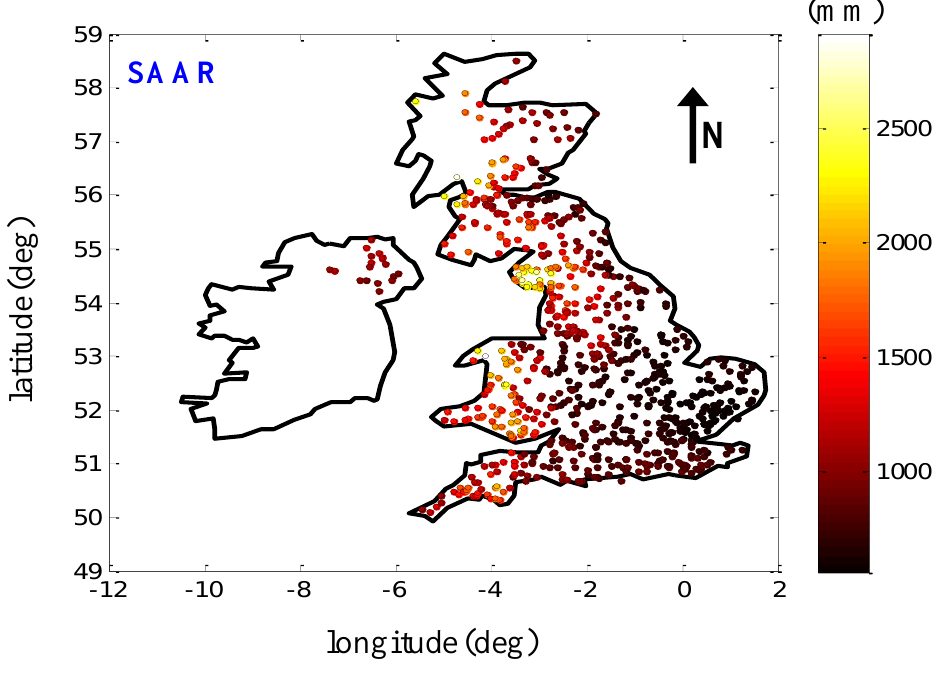
Figure 1. Spatial distribution of the average SAAR values for the 805 considered catchments across the United Kingdom.